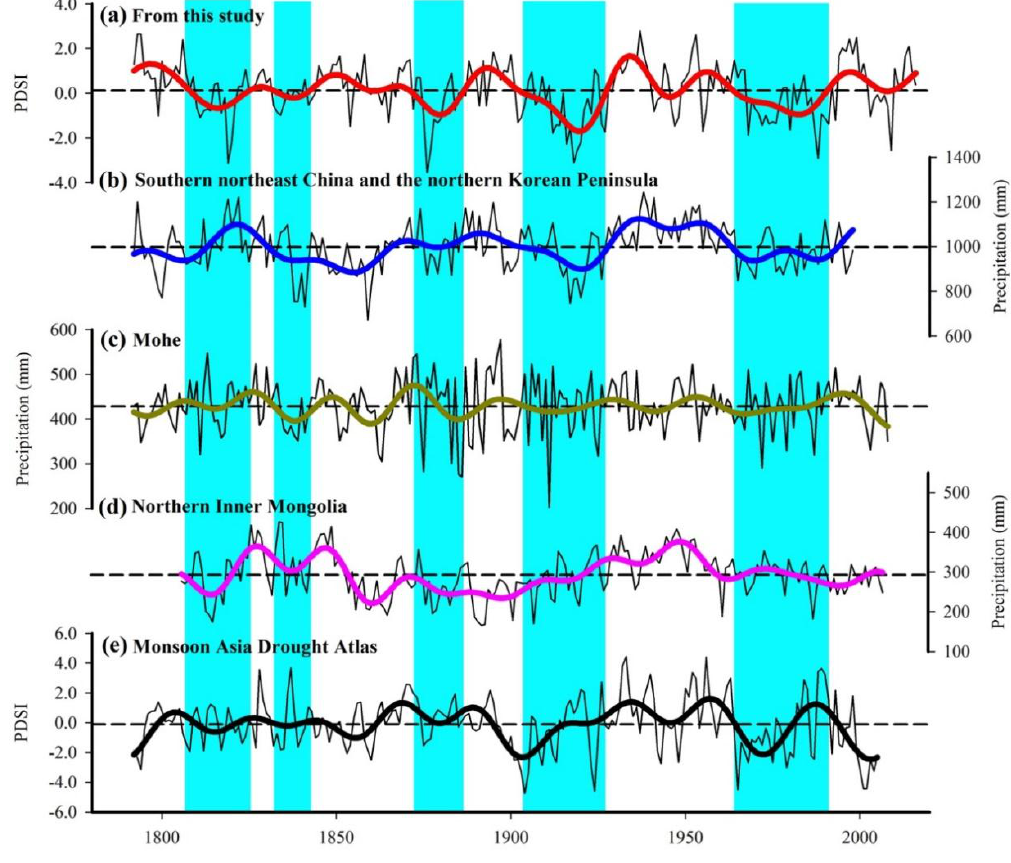
Figure 9. Comparison of PDSI p6-7 reconstruction with reported PDSI and precipitation records from surrounding regions. ( a ) PDSI p6-7 reconstruction in this study; ( b ) October–September precipitation reconstruction in southern northeast China and the northern Korean Peninsula [38]; ( c ) August–July precipitation reconstruction for the Mohe region in the northern Daxing’anling Mountains [25]; ( d ) August–June precipitation reconstruction for the forest–steppe ecotone in northern Inner Mongolia, China [3]; ( e ) drought reconstruction of “Cook” from the same PDSI grid derived from the Monsoon Asia Drought Atlas [39]. All series were smoothed with 20-year FFT smoothing to emphasize long-term fluctuations (low frequency). Blue (dry) shading are low PDSI zones with good agreements.